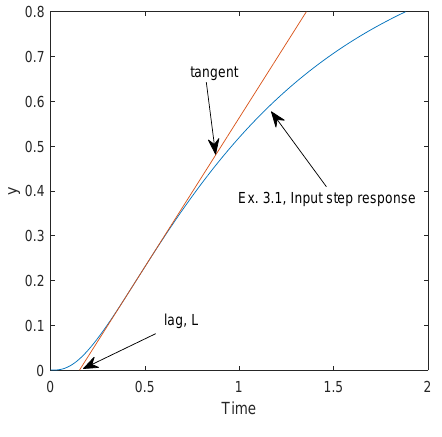
Figure 2: Illustration of the Ziegler’s lag.